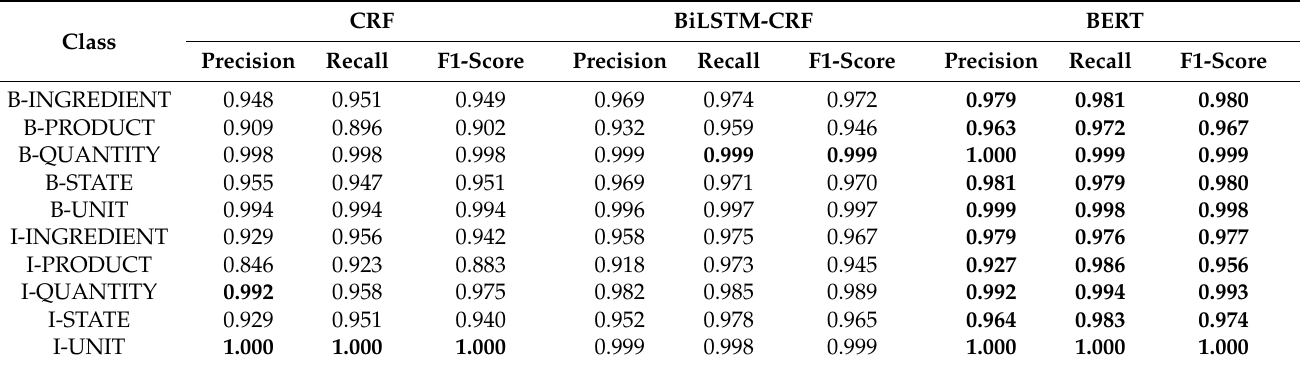
Table 9. The classification report for each models and the best performance is emphasized in bold.